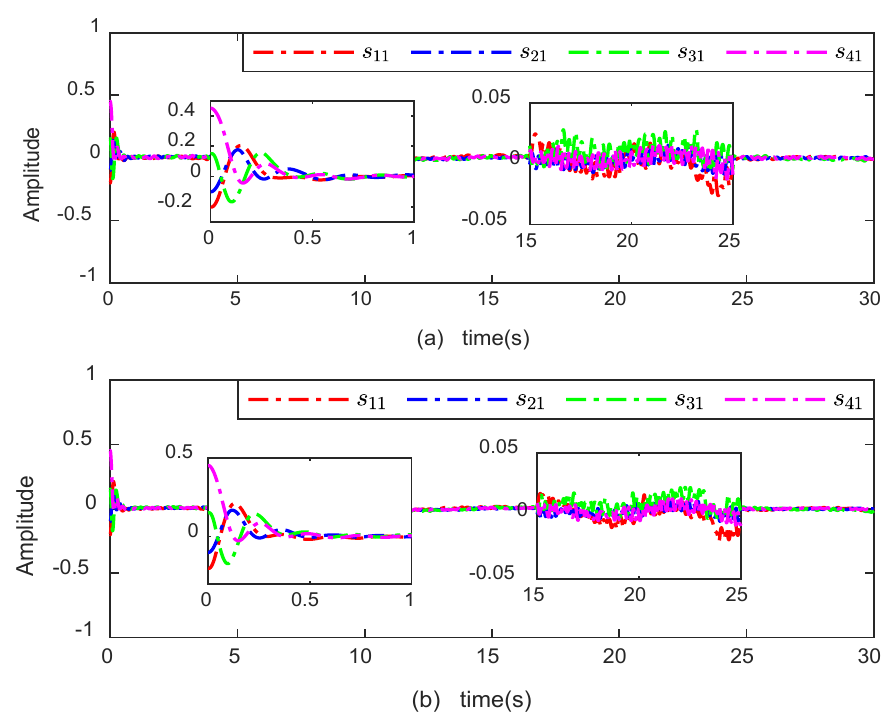
Figure 5. The trajectories of the error surfaces s i ,1 ( i = 1, · · · ,4 ) . ( a ) with quantized control. ( b ) with- out quantized control.